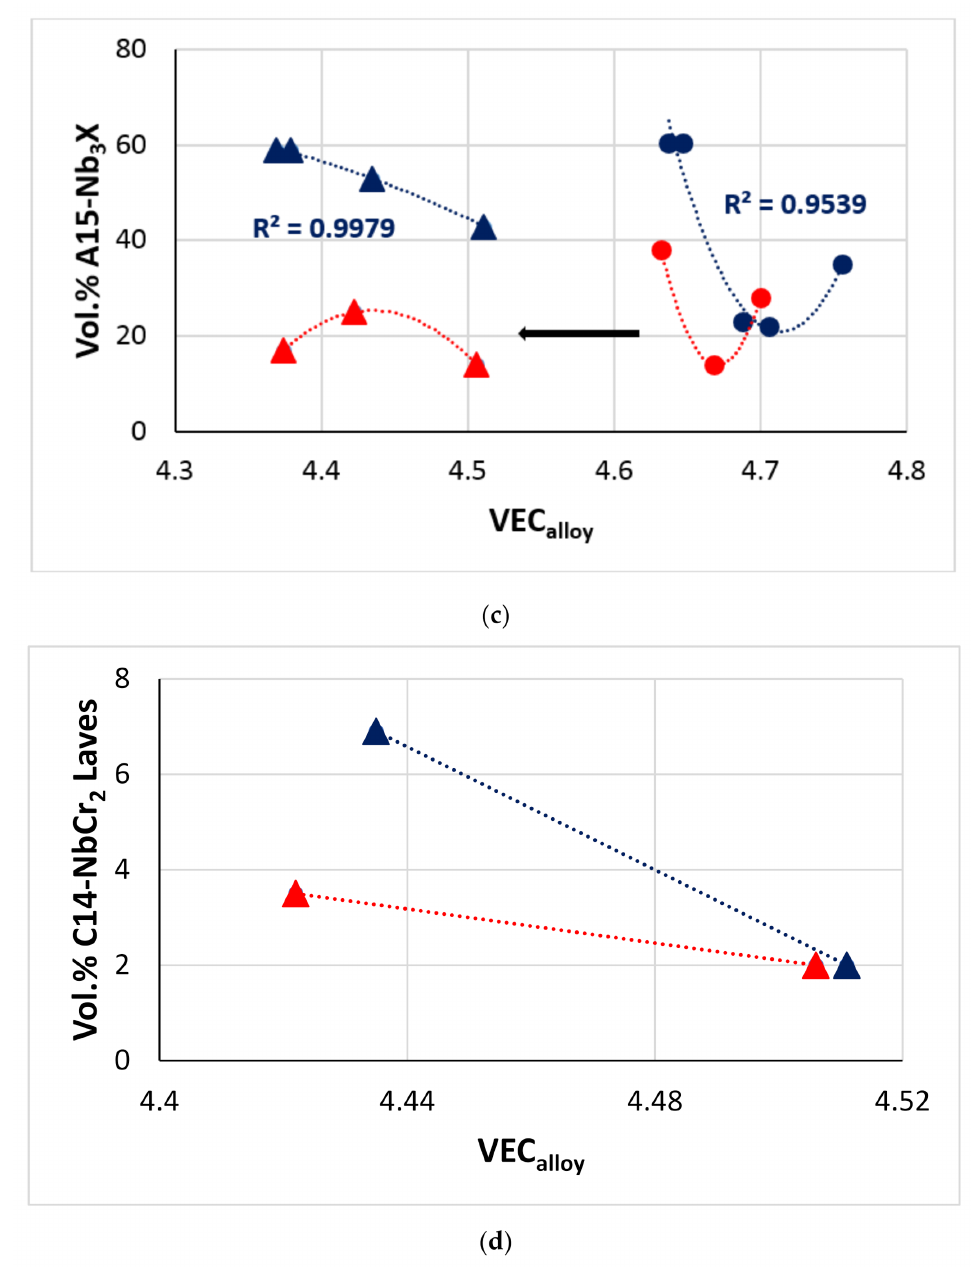
Figure 18. Correlation of the volume fraction of the phases in RM(Nb)ICs with/without Ti addition with the parameter VEC of the alloys that were studied in [26] and this work: ( a ) Nb ss , ( b ) Nb 5 Si 3 , ( c ) A15-Nb 3 X, and ( d ) C14-NbCr 2 Laves phase. Colors and symbols as follows: red for as-cast alloys, blue for HT alloys, circles for Ti-free alloys, and triangles for Ti-containing alloys. In ( a – c ), the black arrow indicates the effect of Ti addition. In ( a , d ), the dotted lines are given to “guide the eye”. Notice (a) that the vol.% of Nb ss , Nb 5 Si 3 , A15-Nb 3 X, and C14-NbCr 2 Laves